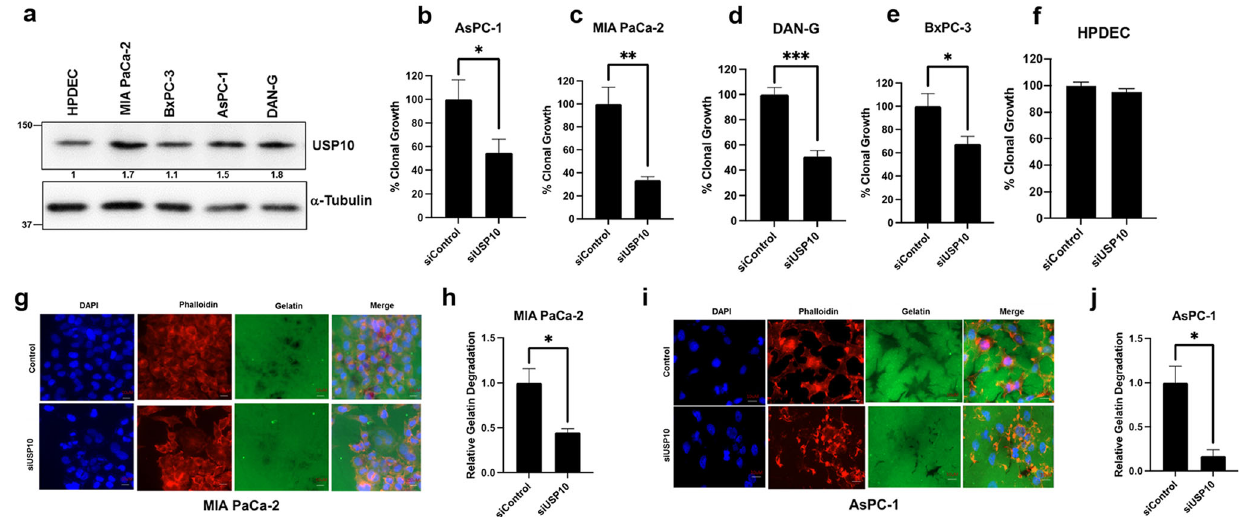
Fig. 2 Cell line expression and cellular phenotypes of USP10 silencing. a Immunoblot showing expression of USP10 in pancreatic cancer cell lines along with normal HPDEC cells. The numbers denote densitometric quantitation of USP10, normalized with respect to α -Tubulin by NIH Image J. b – e Anchorage-independent clonal potential evaluated in control and USP10 silenced pancreatic cancer cell lines and HPDEC. Percent clonal growth along with SD is plotted and compared to their respective siCTL which was set to 100%. Student ’ s t -test was performed for statistical analysis and P < 0.05 was considered signi fi cant; Experiments were repeated independently at least 3 times. ( g – j ) AsPc-1 and MiaPaCa-2 cells were transfected with either non-target control siRNA (siCTL) or siRNA targeting USP10 (siUSP10). 72 h post-transfection, cells were fi xed and stained with DAPI (blue), FITC-gelatin (green), and phalloidin (Tubulin, red). Relative FITC-gelatin matrix degradation i.e., ability to migrate and invade, in siCTL and siUSP10 transfected cells is quantitated; Cells that showed FITC-gelatin degradation were counted and this was set to 1 in the control group. Similarly, in the USP10 silenced group, cells that showed gelatin degradation were counted and expressed relative to the control; >100 cells were evaluated, Data represent mean ± SD; Student ’ s t -test was performed for statistical analysis and * P value < 0.05. (Scale Bar = 10 μ